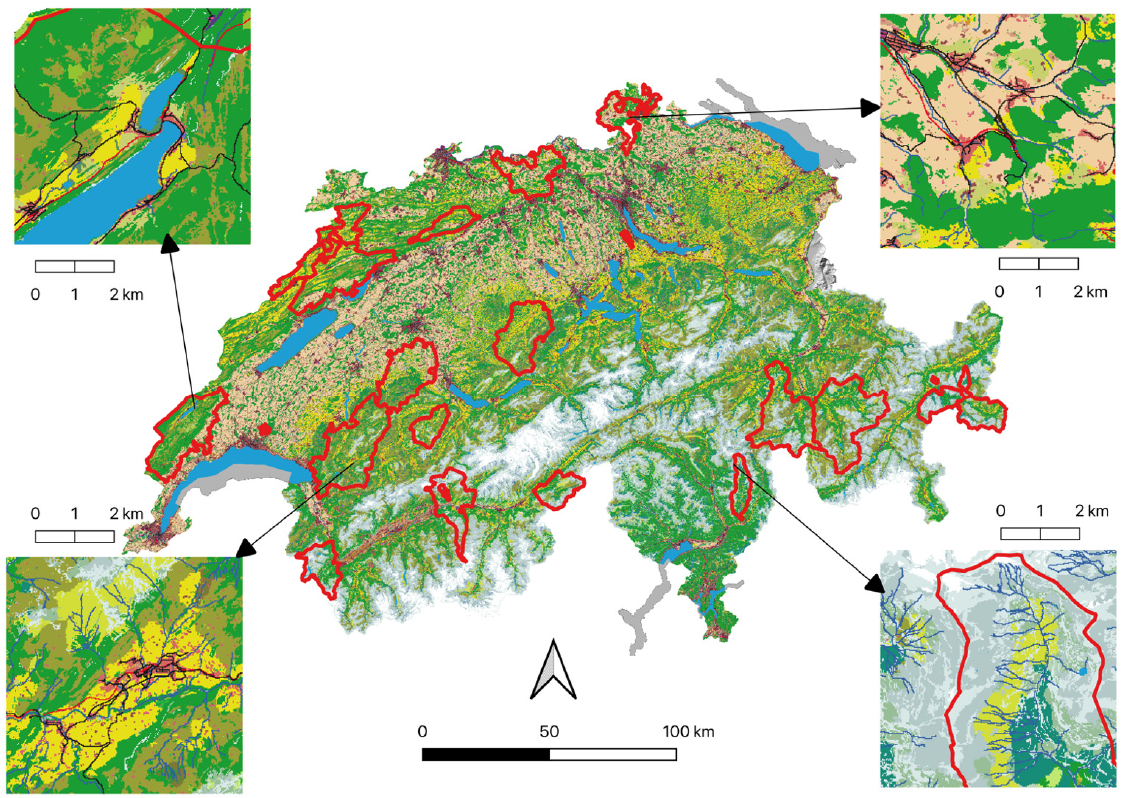
Figure 5. Land use downscaling at 25 m of Switzerland for the 2013–2018 period. Swiss regional parks boundaries in red. (See Figure 6 for legend interpretation.)